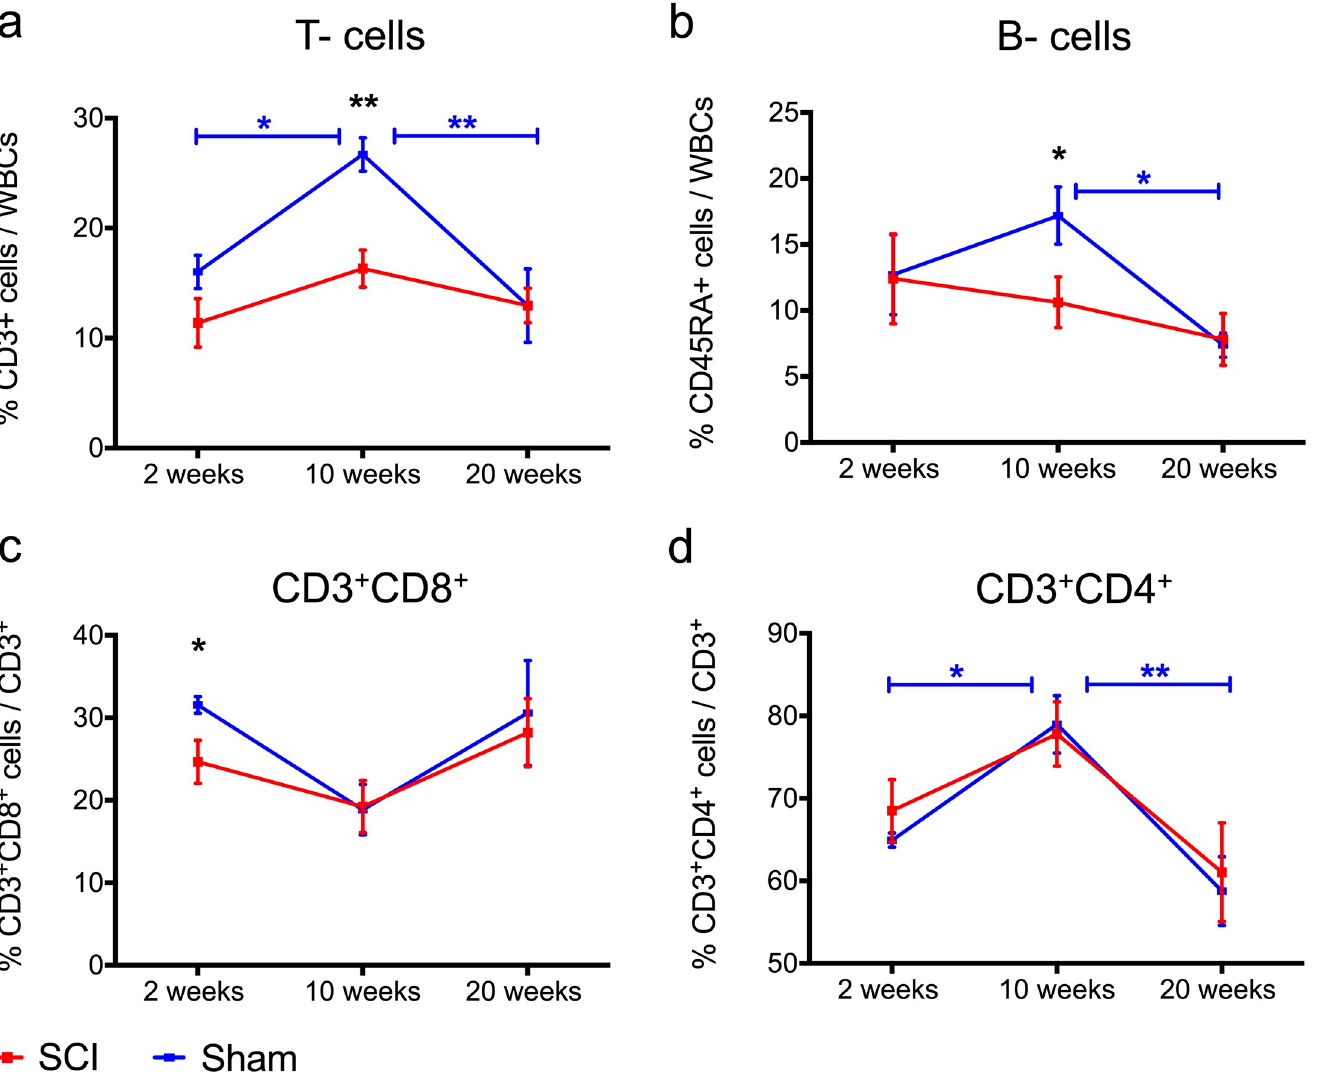
Fig 4. Significant decline in circulating T- and B-cell frequencies after cervical SCI compared to sham-operated rats. (a-b) T- and B-cell frequencies in rats with cervical SCI were significantly lower than in shams at 10 weeks post-injury. These frequencies did not change with time post-cervical SCI, whereas in shams T- and B- cells exhibited time-dependent changes; with (a) T- cells marking a significant increase from 2 to 10 weeks and a drop from 10 to 20 weeks, whereas (b) B- cell proportions declined from 10 to 20 weeks p.i. (c) CD8 + T- cell frequencies dropped at 2 weeks post cervical SCI, compared to shams, but no overall time-dependent changes were observed within each injury group. (d) CD4+ T- cells were similar between injury groups, although only CD4 + T- cells in sham animals showed time- dependent changes; with a significant increase from 2 to 10 weeks and a decrease from 10 to 20 weeks. For all data Independent Student’s t-tests were performed to analyze differences between sham and cervical SCI groups at each time point. Within each injury group, one-way ANOVA with Bonferroni post hoc tests between weeks was conducted to compare time-dependent changes. � p < 0.05, �� p < 0.01 (black � refers to difference between sham and SCI, blue and red � refer to time- dependent difference within the SCI or sham group following post-hoc testing, respectively); N = 5–7 (2 weeks), 6 (10 weeks), 7 (20 weeks) rats/ injury group, mean ±